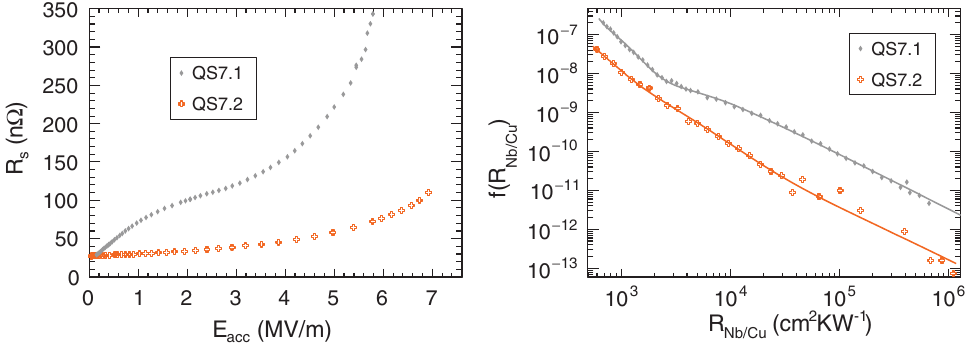
Þ curves for QS7.1 and QS7.2 (left) and their distribution function f ð R FIG. 8. R s ð E acc impedance R (right). The lines are only intended as a guide for the Nb = Cu